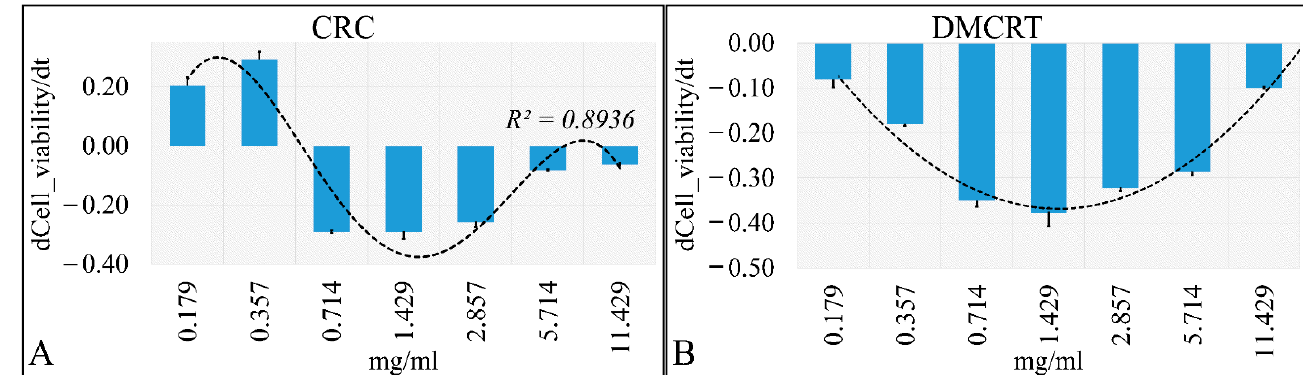
Figure 10. The “speed” by which CRCs and DMCRT reduces cell viability. CRCs manifested a threshold effect from 0.71–2.86 mg/mL, indicating that the induced cytotoxicity was time—independent ( A ). DMCRT manifested a dose-dependent “bell”-shaped behavior, with local maxima at 1.43 mg/mL, indicating that its effects were mostly time-dependent in all cases ( B ) ( Legend : CRCs : Crocins, DMCRT : dimethylocrocetin).